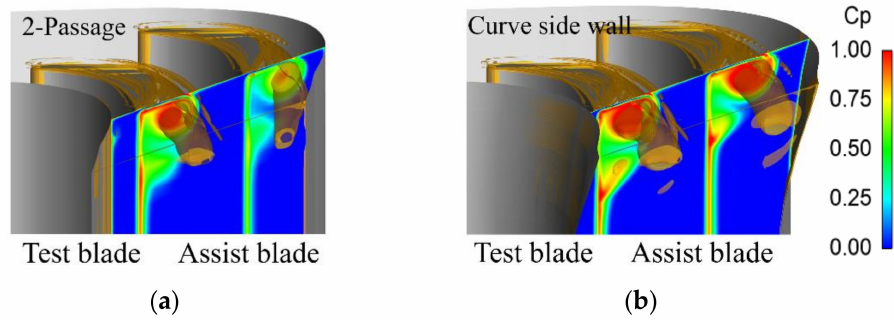
Figure 9. 3D vorticial structure for ( a ) Periodic case and ( b ) 2-Passage curve side wall